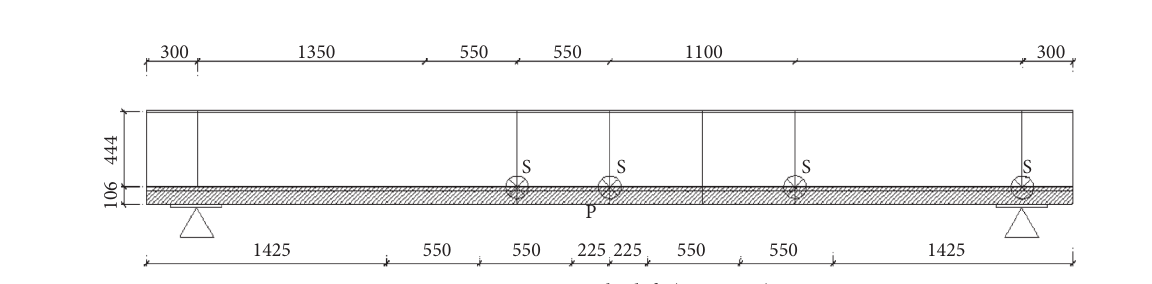
Figure 9: Layout on the left (unit: mm).